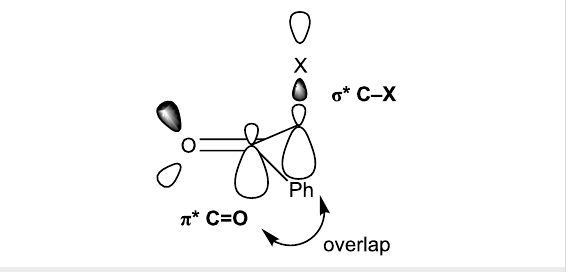
Figure 4: Expected reactive conformation of halo-acetophenones.